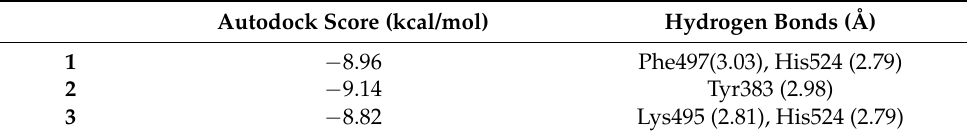
Table 2. Interaction of quaternary isoquinoline alkaloids 1–3 and autodock score for sEH.